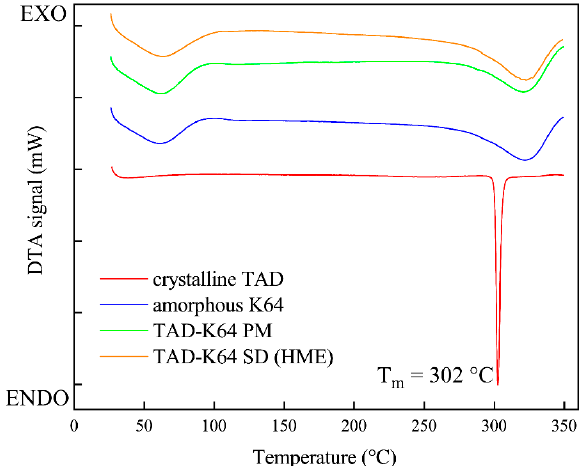
Figure A2. DSC thermograms of (from bottom to top) crystalline TAD, amorphous K64, TAD-K64 PM, and TAD-K164 SD (HME).